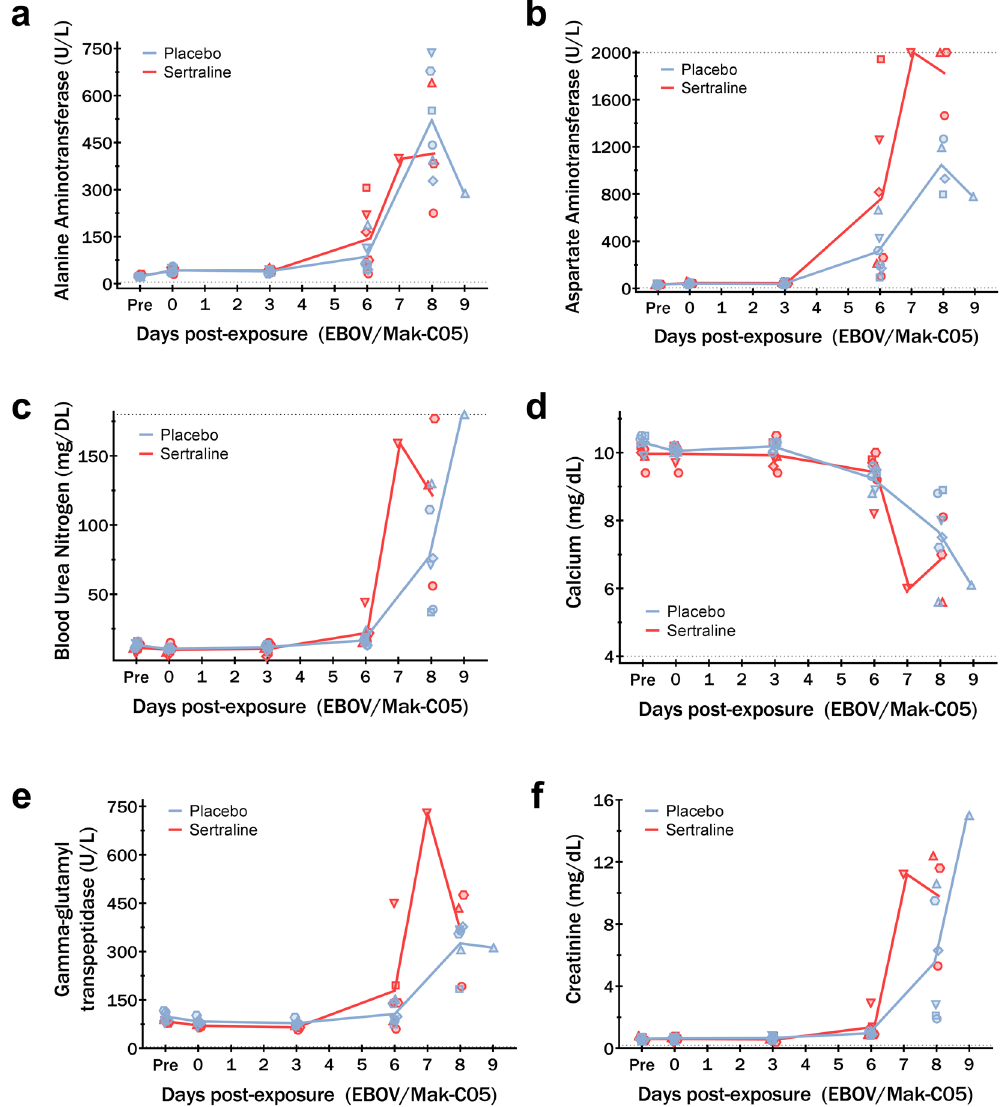
Figure 3. Serum chemistry profiles for sertraline hydrochloride- and placebo-treated macaques. All animals presented with substantial elevation in serum transaminases ( a , b ), alkaline phosphatase (not shown) and gamma-glutamyl transpeptidase ( e ) by day 6 post-exposure. Enzyme levels remained elevated until death. All animals exhibited renal dysfunction with elevated blood urea nitrogen ( c ) and creatinine ( f ) with concomittant decrease in serum total calcium ( d ). Animals were treated with 200 mg sertraline hydrochloride (red) or placebo (blue) by orogastric tube. Group means are presented as lines, with individual values depicted as shapes. Upper or lower dynamic ranges of analytes are shown by dotted lines as